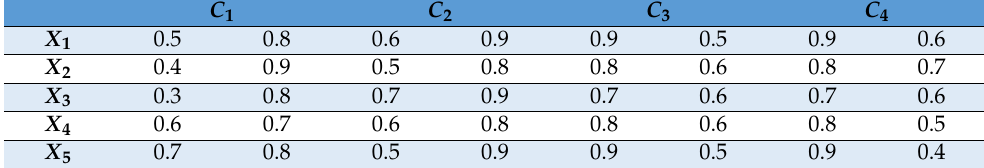
Table 7. Expert e 3 about energy resources under given criteria (after